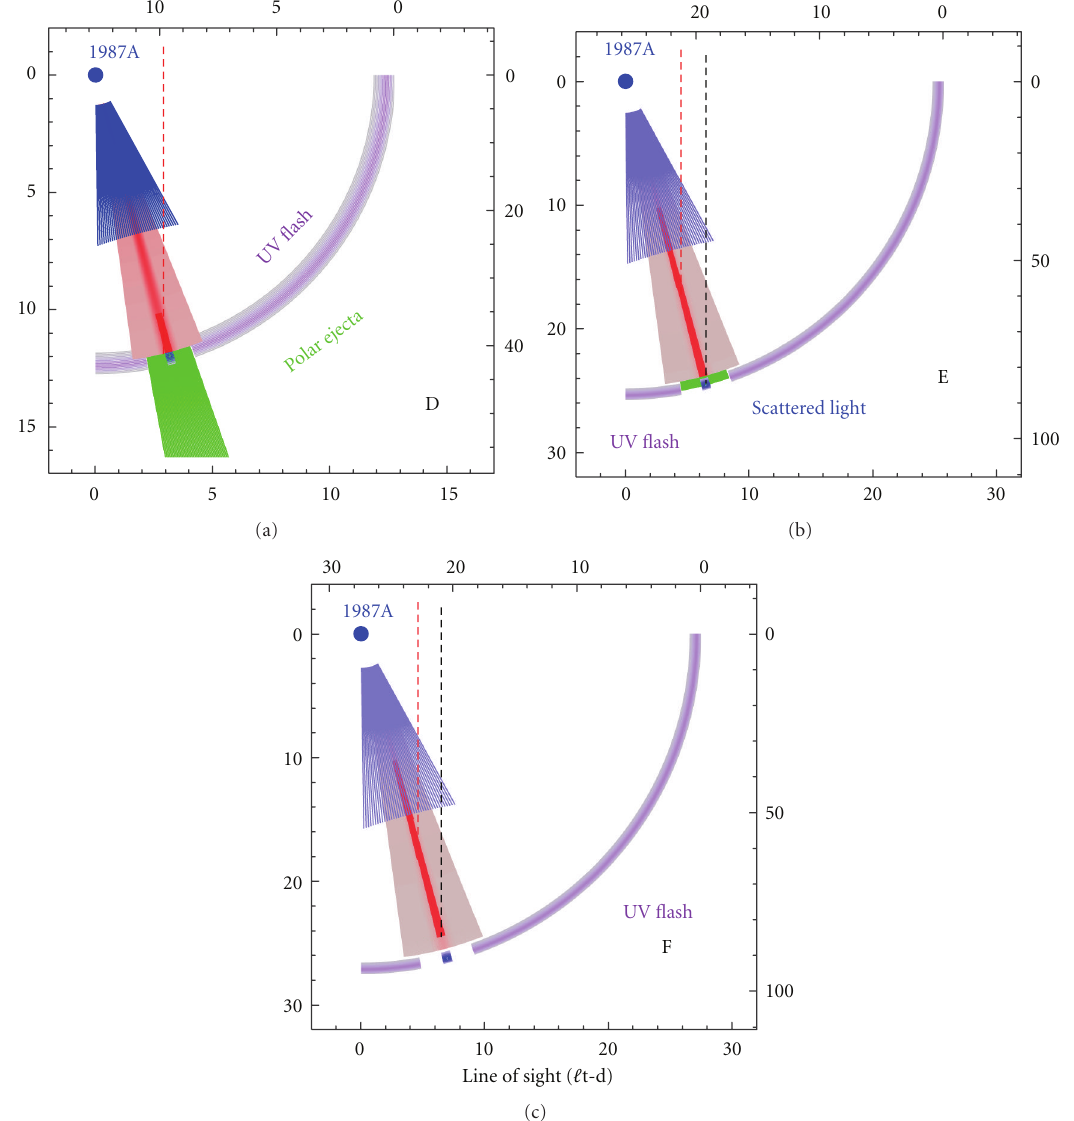
Figure 5: ((a)—D). The intense center ( ∼ 1 ◦ ) of the jet begins to produce light as it penetrates into the polar ejecta, producing the jump in luminosity at day 9.8. ((b)—E) Particles in the jet continue to impact the polar ejecta (mostly hidden), extending the ramp in luminosity visible in Figure 3 near day 20 (left dashed line to the top scale). Right dashed line: light from the filtered UV flash scatters in clumpy polar ejecta near its outer boundary. ((c)—F) The fastest jet particles have cleared the end of the polar ejecta.